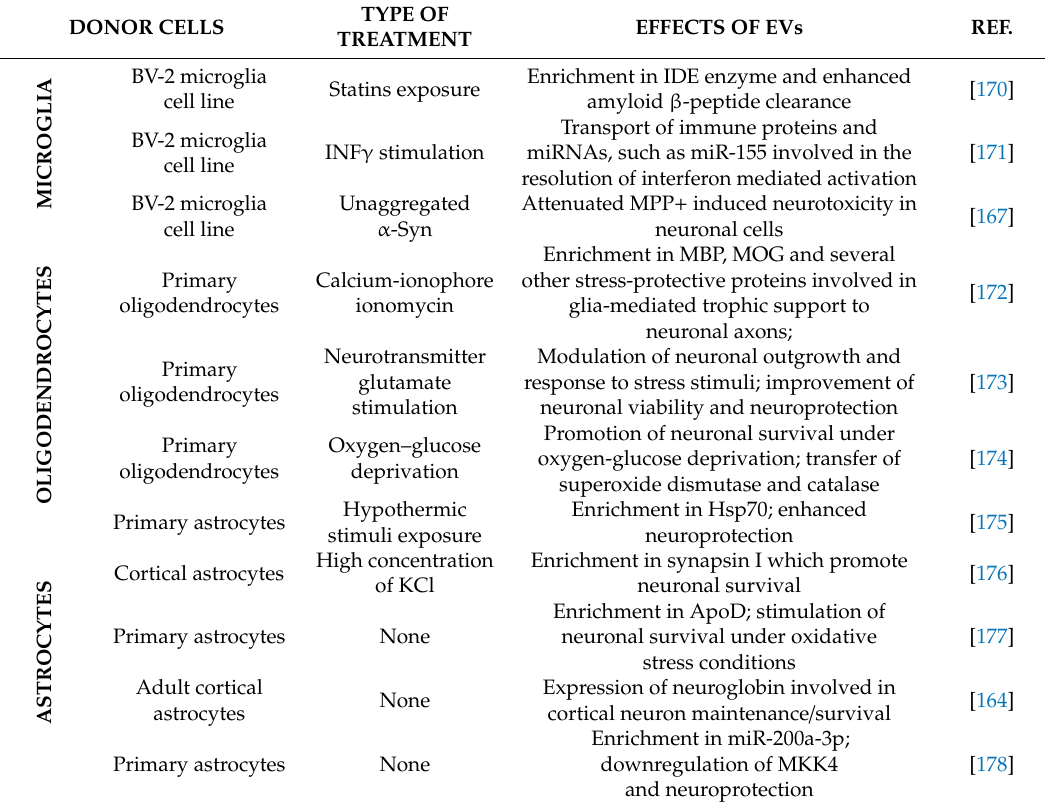
Table 2. Description of beneficial e ff ects mediated by EVs released by microglia, oligodendrocytes or astrocytes on neuronal target cells. TYPE OF DONOR CELLS EFFECTS OF EVs TREATMENT